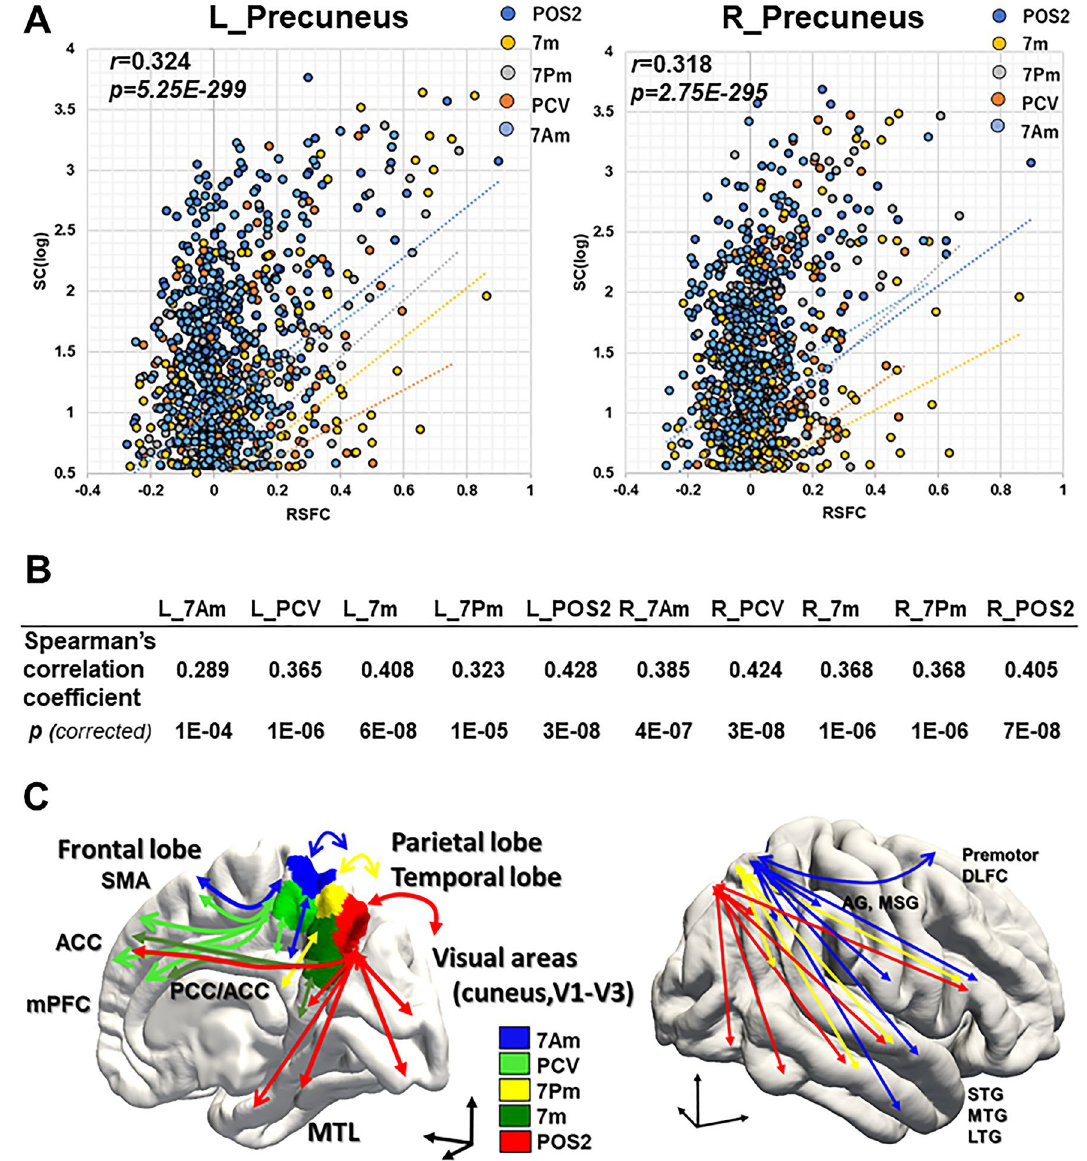
coefficient between each precuneus ROI (7Am, PCV, 7Pm, 7m, POS2) and the other cortical areas (180 in HCP MMP atlas) in the left (L) and right (R) hemisphere, respectively. ( C ) Schematic diagrams showing